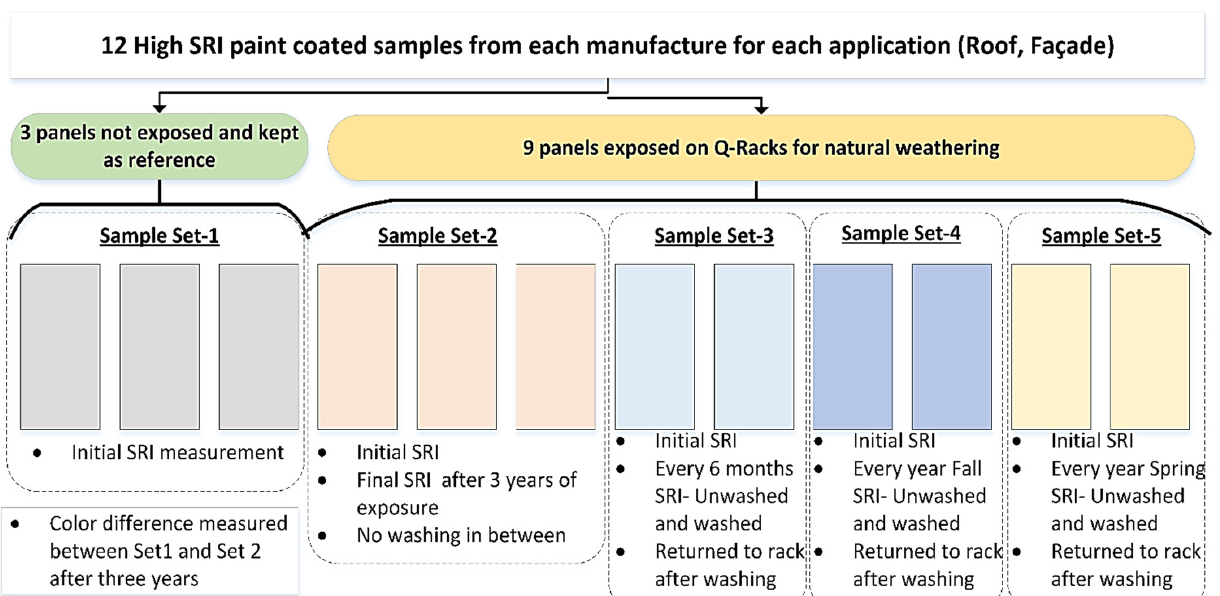
Figure 1. Natural weathering/aging site: Ras Al Khaimah, the UAE [29].